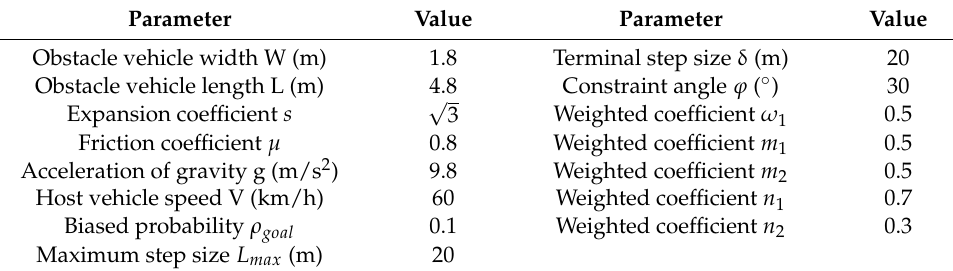
Table 2. Other parameters. Contrast step size ∆ L (m)